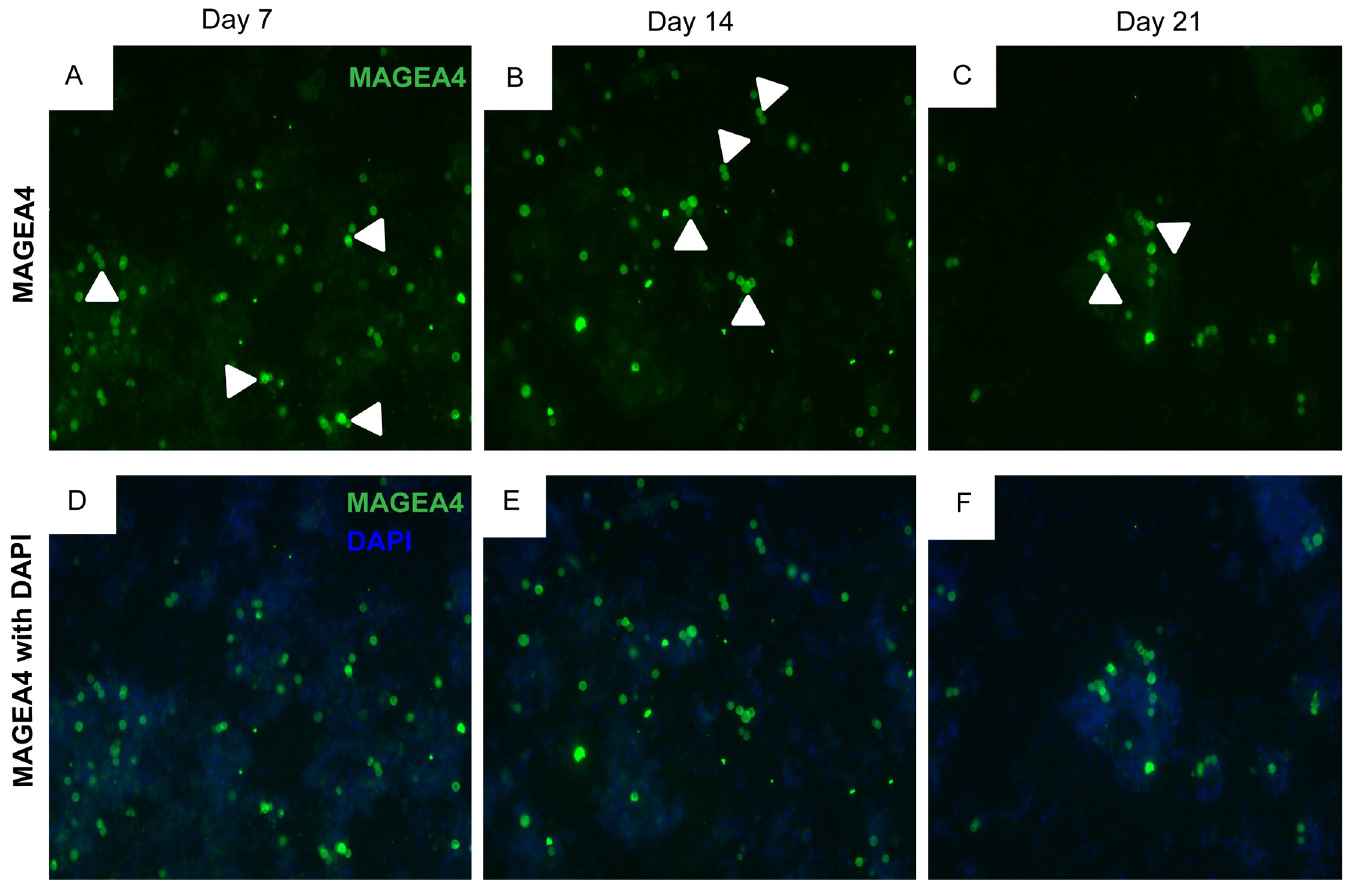
Fig 5. Adult macaque testicular cells cultured in SSC, PS and SM culture conditions were analyzed for expression of the germ cell marker MAGEA4 in vitro . Representative micrographs show cultured cells at day 7, 14 and 21 exhibiting strong expression for spermatogonial marker MAGEA4 as shown in A, B, C (20x; without DAPI) and D, E, F (20x; with DAPI). Cells cultured for 7, 14 and 21 days showing intense expression for MAGEA4 were quantified for each culture condition. Singlets (1c), duplets (2c), triplets (3c), quadruplets (4c), quintuplets (5c), small clusters (sc) of 5–10 cells and big clusters (bc) of > 10 cells, as shown by white arrowheads were quantified for each culture condition and time